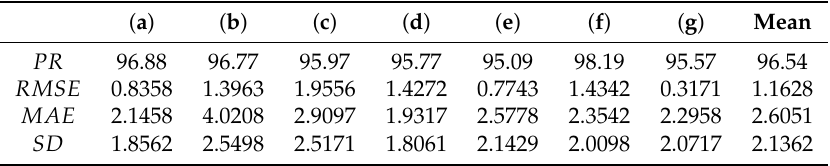
Figure 12. Registration examples on the seven typical satellite image pairs. From ( a ) to ( g ) are: Berlin, Las Vegas, Mekong River, Paris, WuHan, Washington and Hawaii. Columns from the left to the right are: the sensed, reference and transformed images, the 5 × 5 checkboards, and the feature matching results. Blue lines indicate true positive and true negative, red lines indicate false positive and false negative. Table 5. Experimental results on series (III). Quantitative tests on feature matching and image registration are carried out to examine the availability and robustness of our method using the PR, RMSE, MAE and SD. (a) to (g): results on the corresponding pairs of Figure 12. Mean: the mean of results on all image pairs of dataset (iii). For the PR, the units are in percentage, for the RMSE, MAE and SD, the units are in